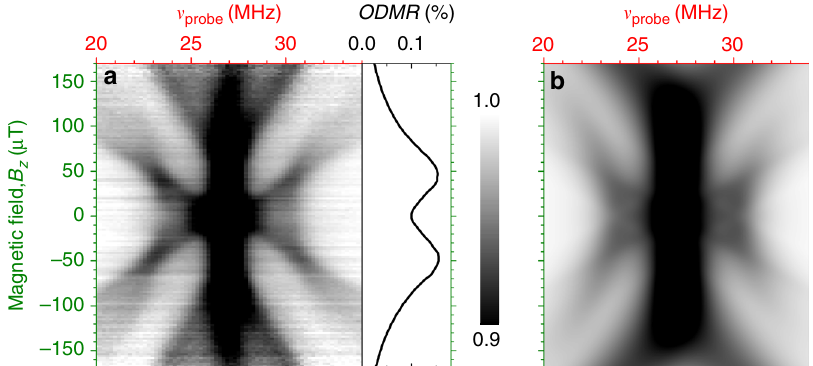
Fig. 2 Visualization of the excited qudit modes. a Magnetic fi eld evolution of the qudit modes in an inhomogeneously broadened spin ensemble. The ODMR signal is normalized for each magnetic fi eld. The base ODMR signal is presented on the right side. b Calculated evolution of the spin qudit modes assuming T = 3 T = 6 T p d f (see text for details)